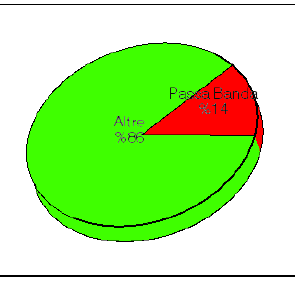
Figure 7. Pie chart of low-pass filter frequencies